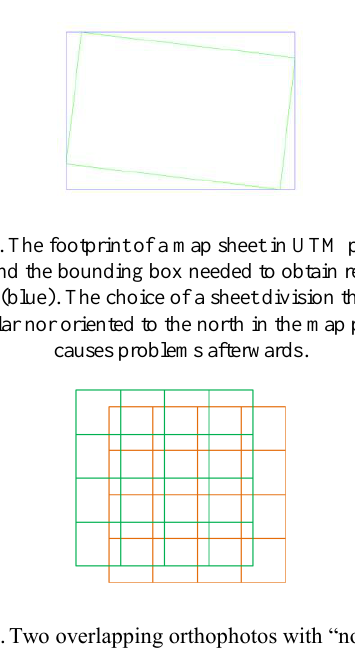
Figure 2. Two overlapping orthophotos with “nonaligned pixels” cannot be mosaicked or even displayed overlaid without resampling one of them